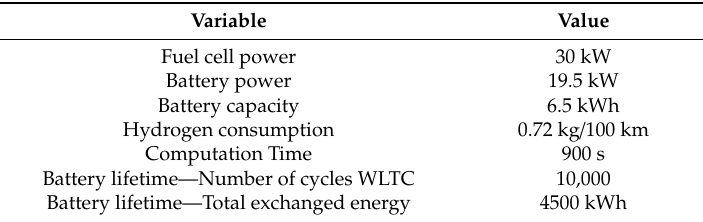
Table 2. Optimization results—WLTC.